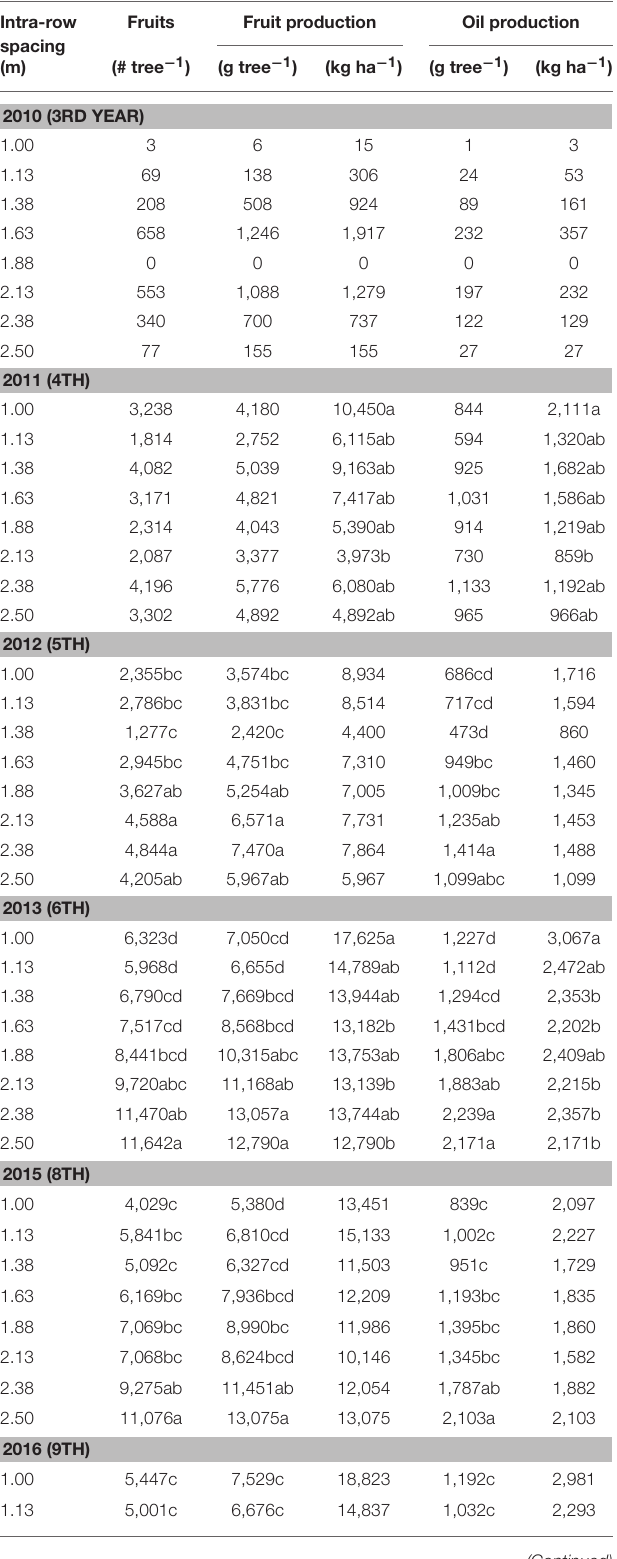
TABLE 4 | Fruit and oil production for the first 6 harvests of trees planted at various intra-row spacing. Intra-row Fruits Fruit spacing